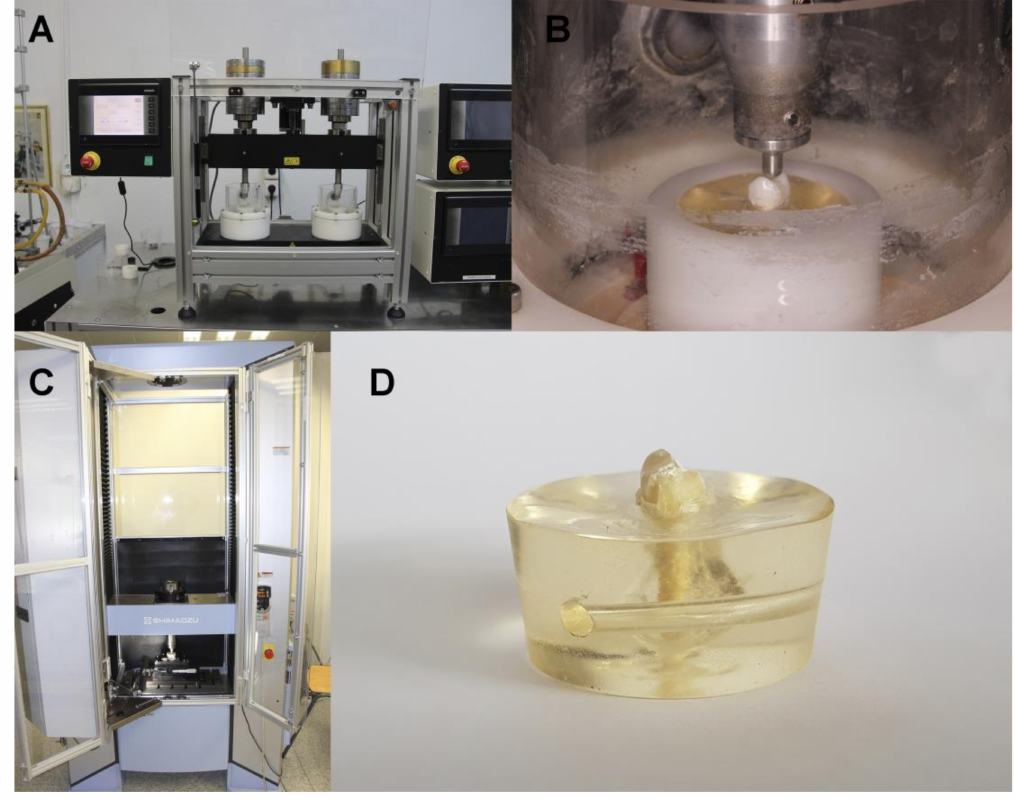
Figure 3. ( A , B ) Samples placed in the thermal and mechanical cycling fatigue device and ( C , D ) sample fractured by static load after bending